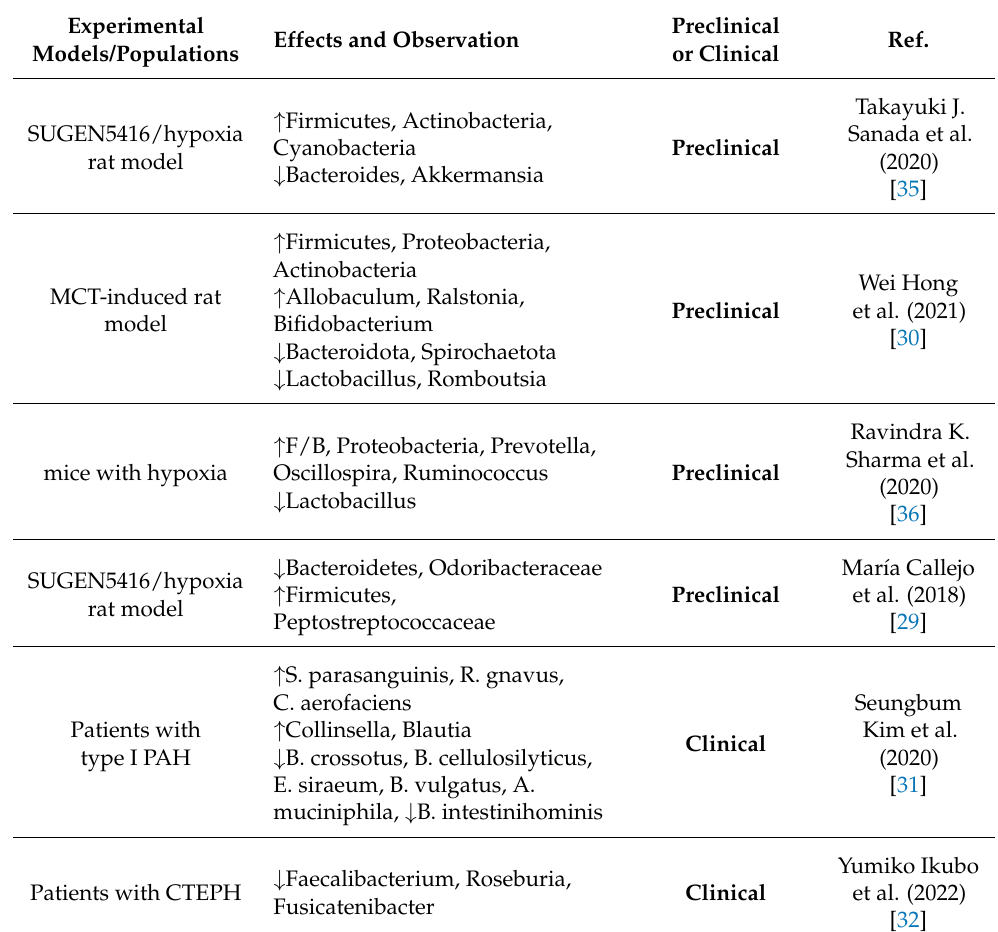
Table 1. Shifts in the gut microbiota composition in pulmonary arterial